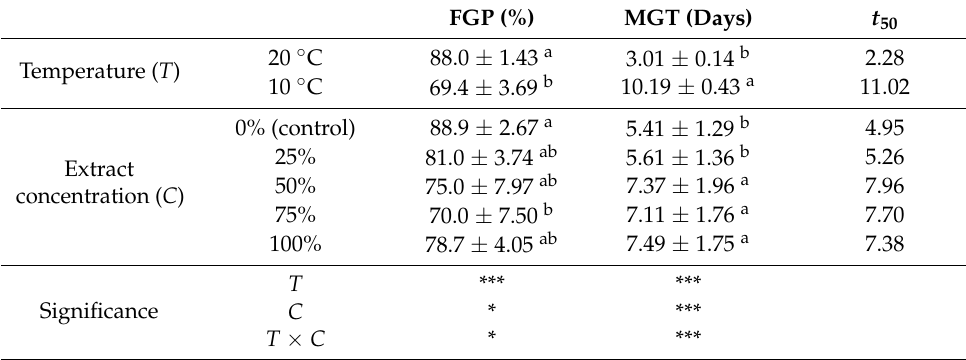
Table 5. Main effects of temperature and hemp leaf extract concentrations on final germination percent- age (FGP), Mean germination time (MGT), and time to 50% germination ( t 50 ), in barley cv. Alamo.